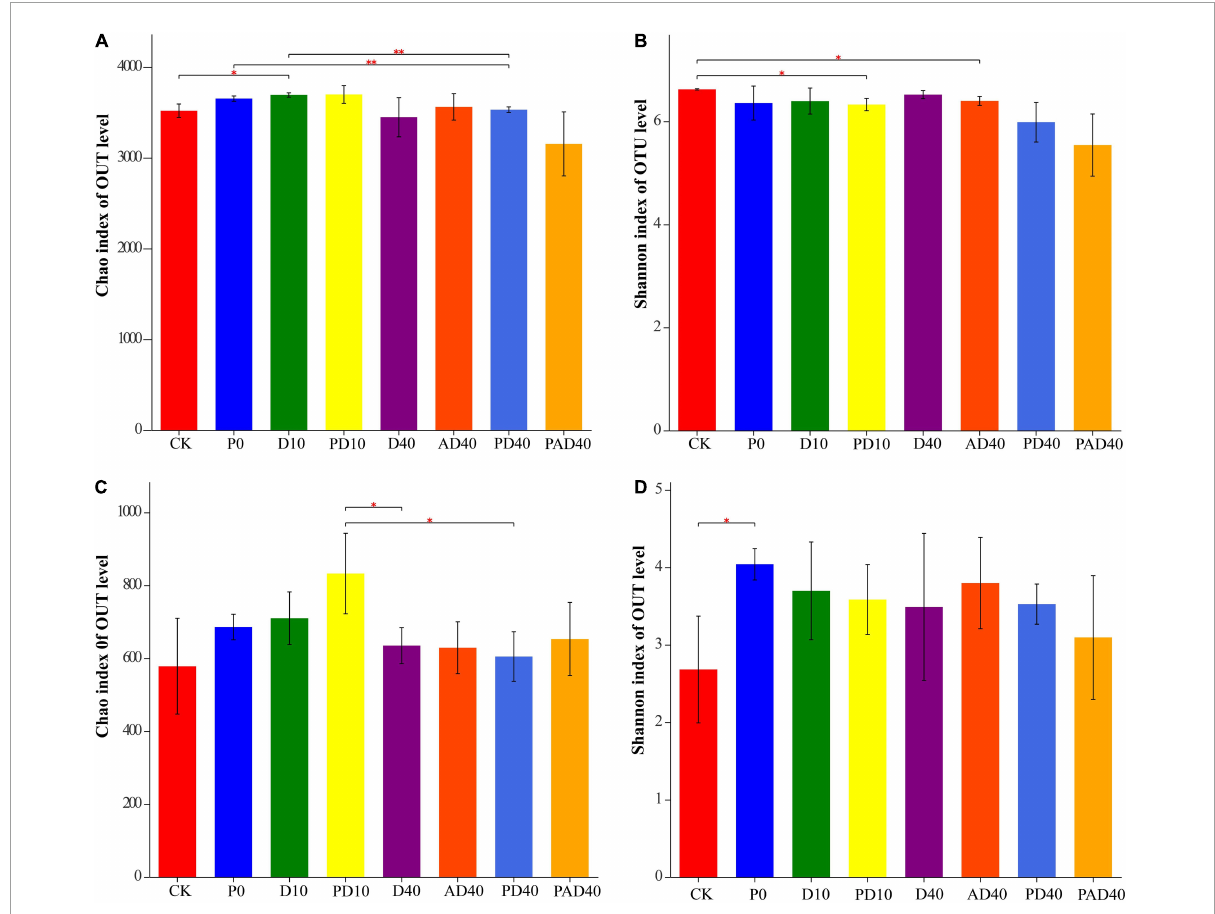
FIGURE3 Effects of PAM and ABA on soil microbial alpha diversity. (A) Chao index of bacterial communities; (B) Shannon index of bacterial communities; (C) Chao index of fungal communities; (D) Shannon index of fungal communities. CK: severe desertified soil grew grass without PAM and ABA treatment; D10, D40: severe desertified soil grew grass with 10 or 40 days drought; P0: severe desertified soil grew grass with PAM but without drought; PD10, PD40: severe desertified soil grew grass with 10 or 40 days drought; AD40: severe desertified soil grew grass with 40 days drought and ABA treatment; PAD40: severe desertified soil grew grass, with 40 days drought, PAM, and ABA treatment. * p < 0.05 and ** p <